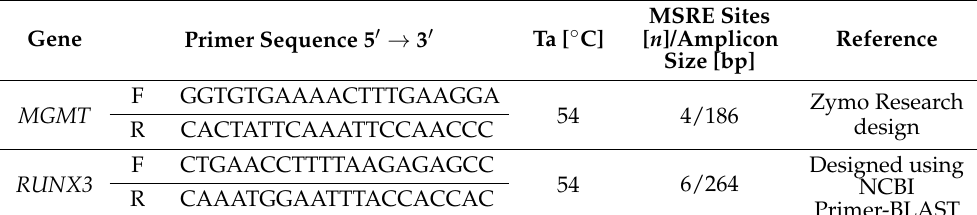
Table 2. Primer sequences.